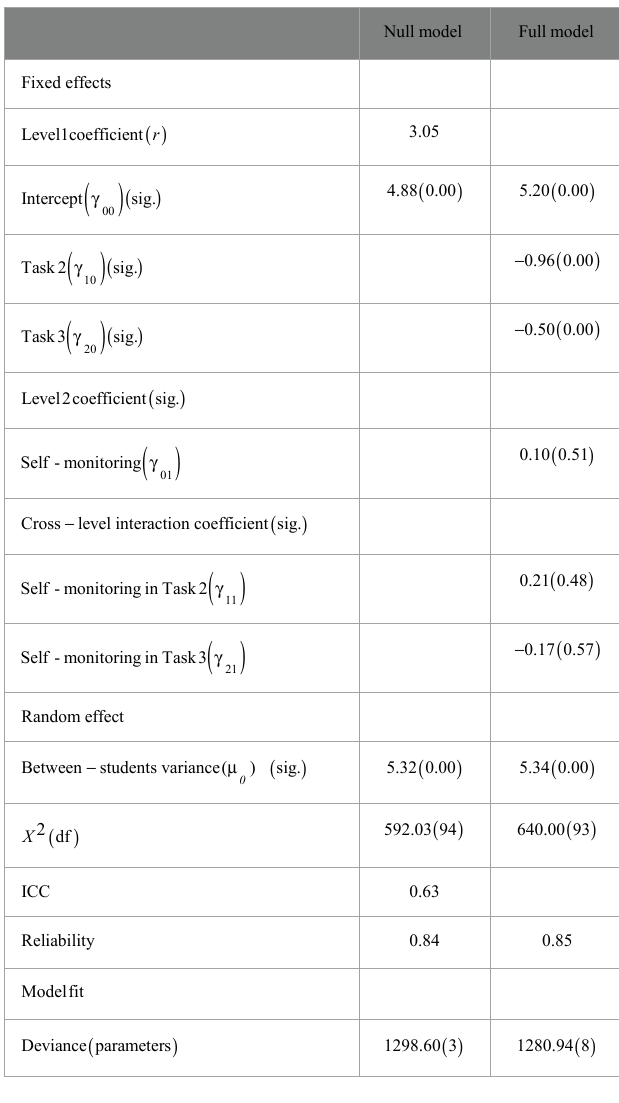
TABLE 2 Results of the null model and the full model.